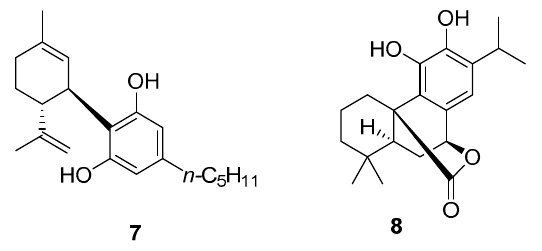
Figure 2. Structure of cannabidiol (CBD, 7 ) and carnosol ( 8 ).